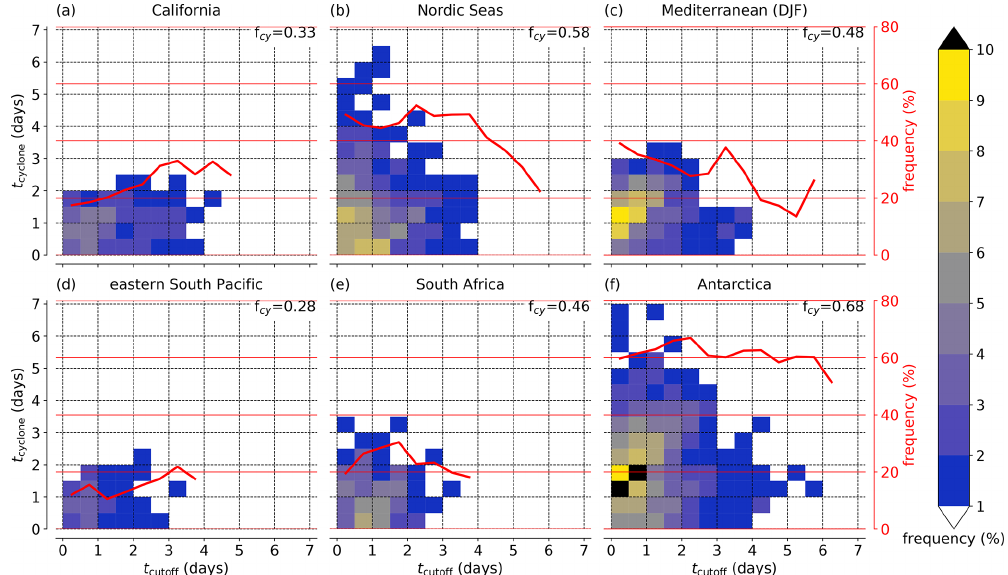
Figure 16. Relative frequencies of PV cutoffs linked to a surface cyclone (shading, in %) as a function of cutoff lifetimes ( t cutoff ) on the horizontal axis and surface cyclone lifetimes ( t cyclone ) on the vertical axis, binned into 12-hourly time intervals. The red contour shows the relative frequency of cutoffs linked to surface cyclones as a function of cutoff lifetime, e.g., the value at day 3 indicates the percentage of PV cutoffs with a lifetime of at least 3d that are linked to a surface cyclone at day 3. PV cutoffs positioned in the lowermost row of the diagram are linked to a surface cyclone within 12h after surface cyclogenesis, and PV cutoffs positioned in the leftmost column of the diagram are linked to a surface cyclone within 12h after PV cutoff genesis. The relative frequencies of PV cutoffs with at least one link to a surface cyclone during their life cycle are indicated at the top right in each panel ( f cy ). Shown are results for PV cutoffs with genesis in DJF in the regions: (a) California, (b) Nordic Seas, (c) Mediterranean, (d) eastern South Pacific, (e) South Africa, and (f) Antarctica.